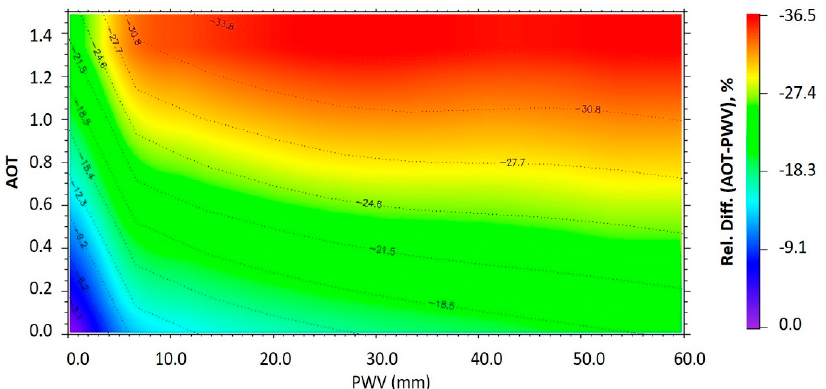
Figure 1. Aerosols–precipitable water vapour (AOT-PWV) effect (Rel.Dif (AOT-PWV), %) estimated by Obregón et al. [24] for each combination of AOT and PWV values.